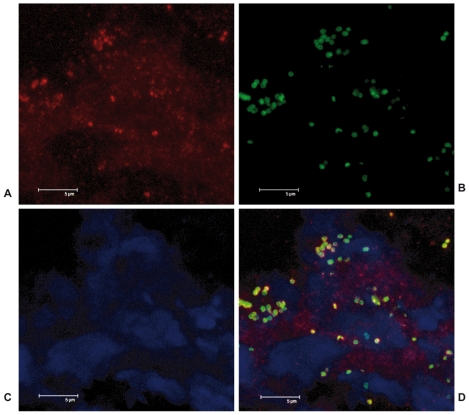
Co-localization of PCI and Streptococci at the infectious site.Tissue biopsies (see Figure 7) were stained for (Alexa 594, red, A) and S. pyogenes (Alexa 488, green, B). Cellular infiltrates are indicated in blue by the DNA binding stain DAPI (C). The yellow stain illustrates areas where bacteria and PCI are co-localized (D). Bar: 5 µm.